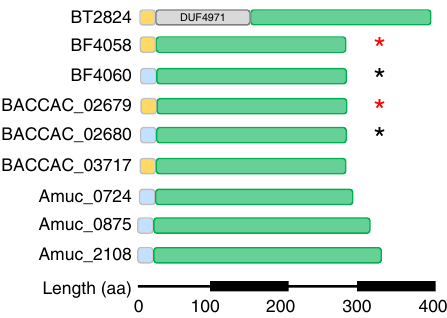
Fig. 2 Domain structure of the mucin-associated GH16 enzymes characterised in this study. GH16 catalytic domain (green), Type I signal peptide (light blue), Type II signal peptide (orange). BT2824 also has an N- terminal DUF4971 domain (PF16341) of unknown function. Sequence identity is between 22 and 38% for most of the enzymes, but two pairs of the GH16 enzymes are close homologues - BF4058 and BACCAC_02679 (red asterisk) display 87% identity, while BF4060 and BACCAC_02680 (black asterisk) display